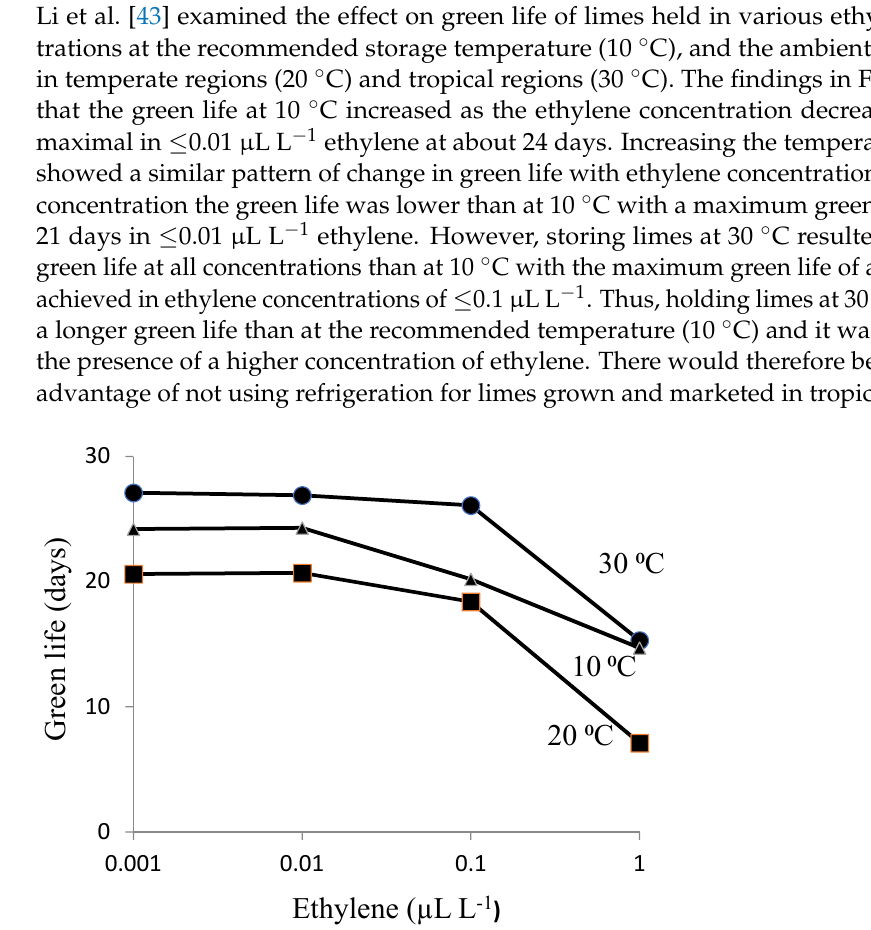
Figure 4. Green life of limes stored at different temperatures and ethylene concentration. Graph generated from data given in Li et al. [42].